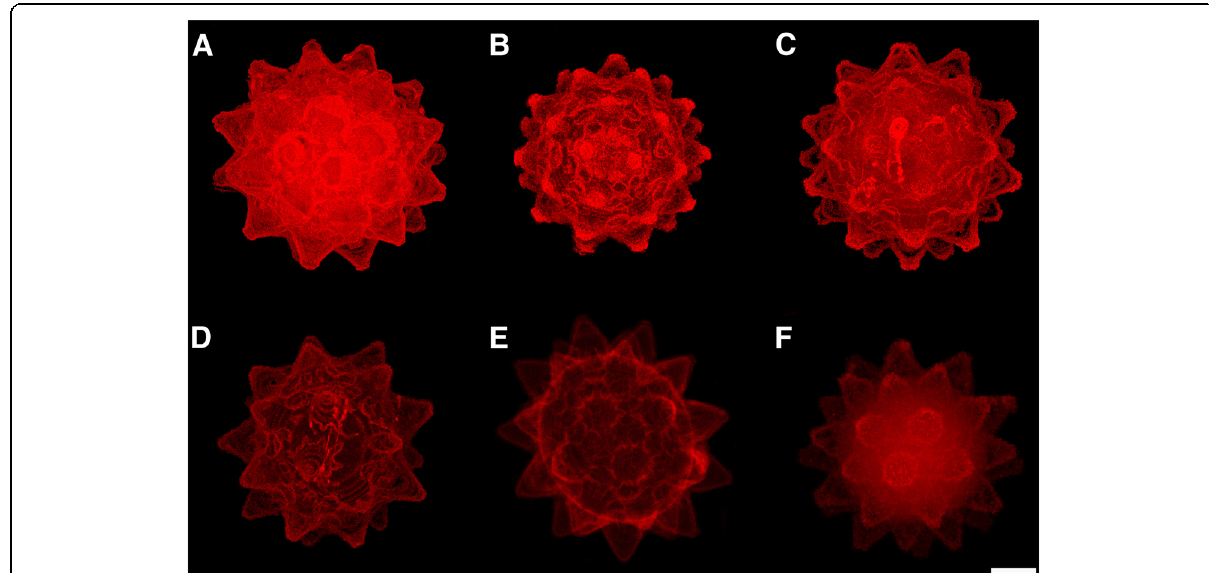
Fig. 8 Eggs of the Paramacrobiotus populations (CLSM). a Formigine. b Passo Ballino. c Pondel (the buccal-pharyngeal apparatus of the embryo